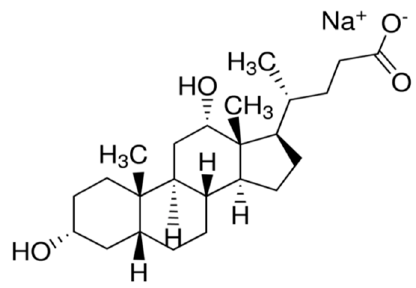
Figure 1. Structure of Sodium deoxycholate (NaDC).